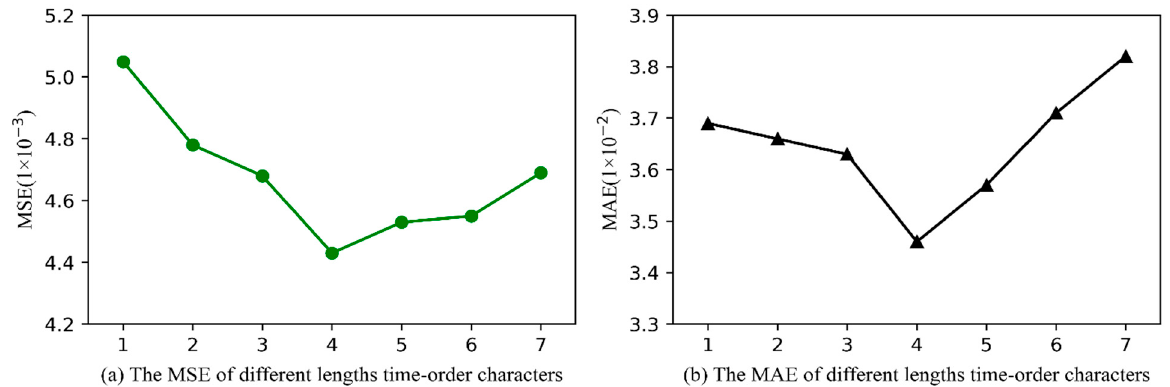
Figure 7. Error curve of time-order characters with different lengths. ( a , b ) are the MSE and MAE of different lengths time-order characters, respectively.